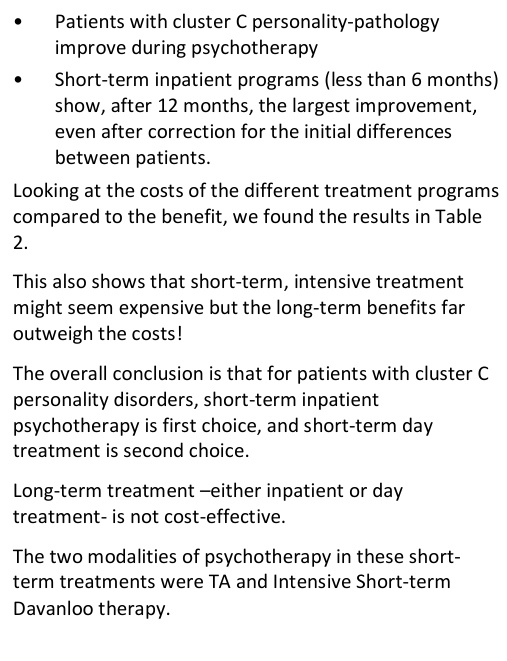
Figure 4: Symptomatic improvement by PD